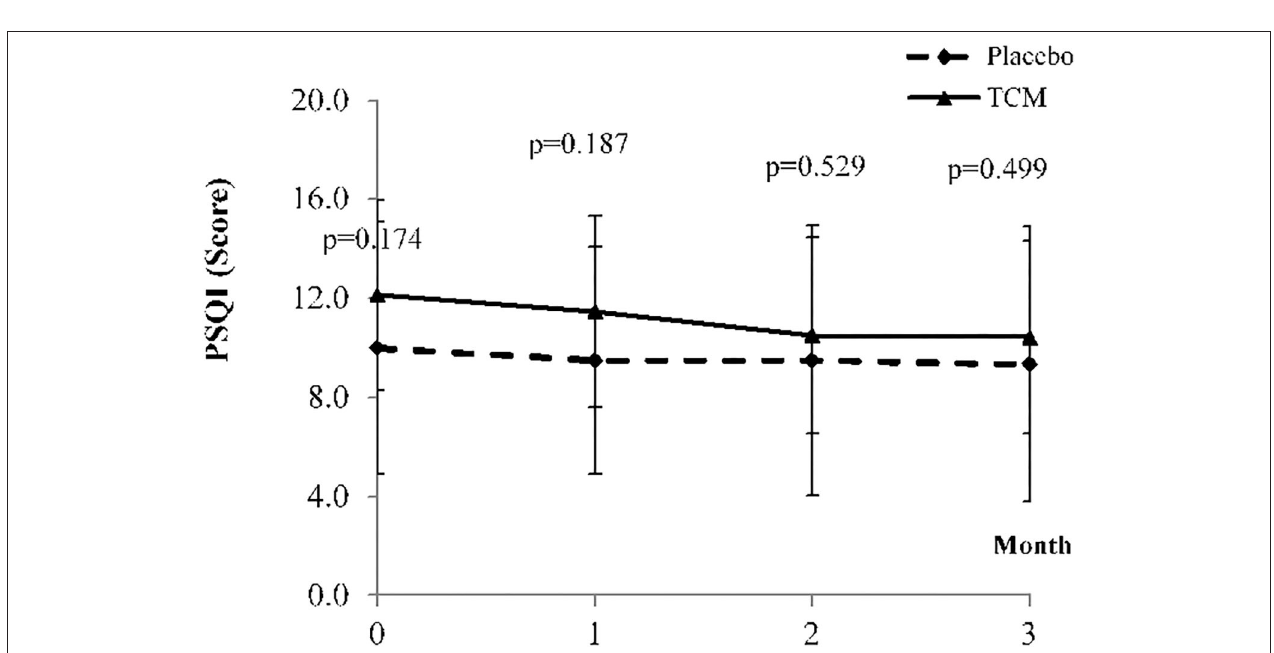
FIGURE 3 | Means and standard deviation of PSQI at baseline and weeks 4, 8, and